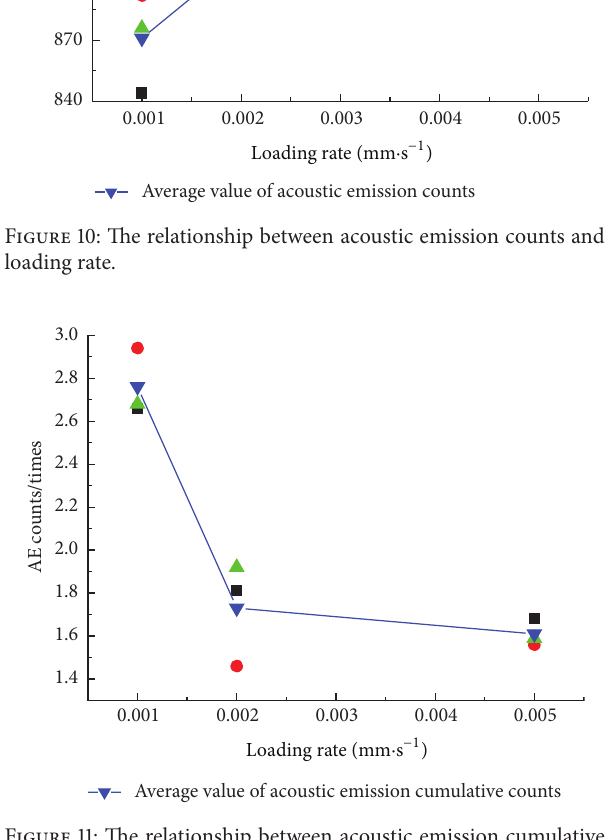
Figure 11: The relationship between acoustic emission cumulative counts and loading